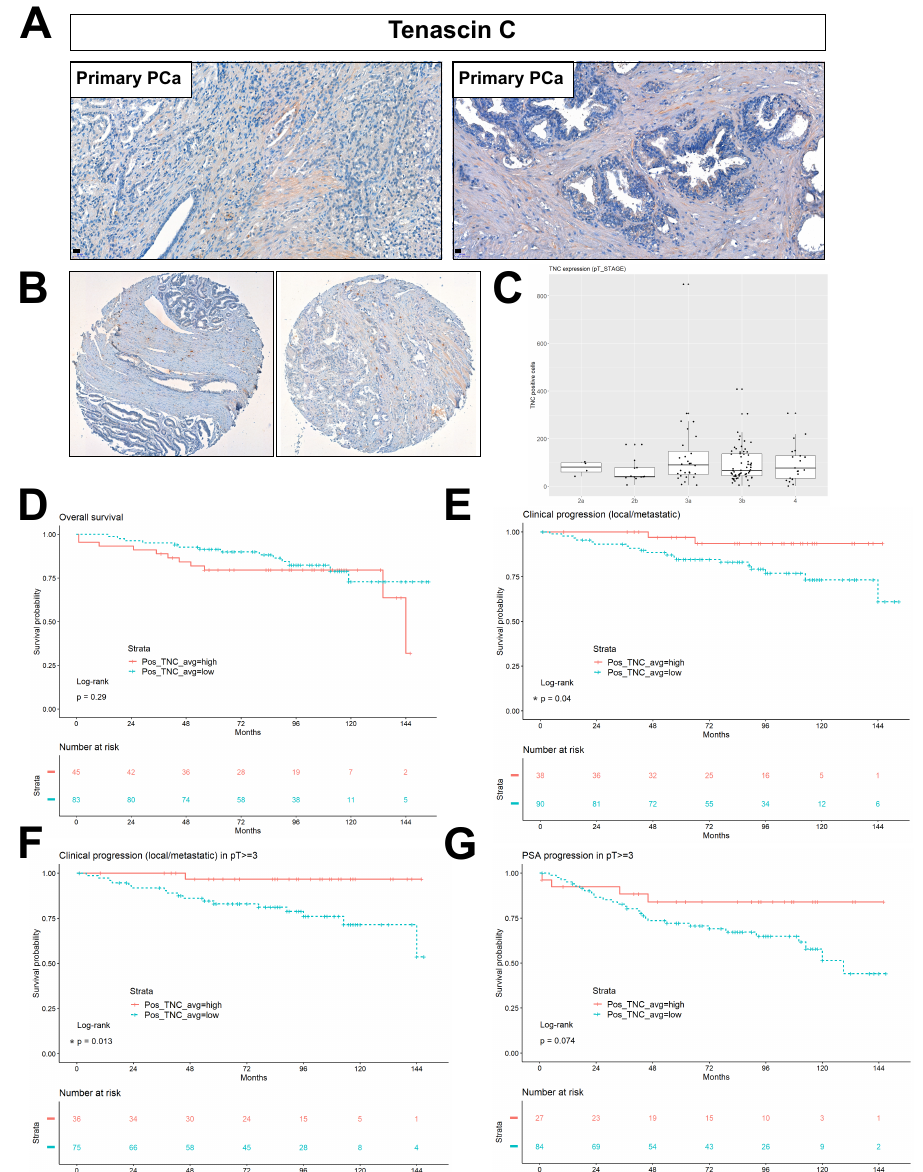
Figure 7. TNC protein expression is a negative metastasis prognostic factor in primary, high-risk PCa. ( A ) Validation of the protein expression and stromal specificity of TNC by immunohistochemistry in primary PCa cases. ( B ) Representative cases of TNC staining on primary PCa Tissue Microarray (TMA) from European Multicenter Prostate Cancer Clinical and Translational Research Group (EMPaCT). ( C ) TNC expression levels in terms of the no. of positive cells in the pT Stage classification. Statistical multiple comparison test, the Wilcoxon rank sum test, was performed; p > 0.05 ( D ) Overall survival probability in patient groups of TNC-high and TNC-low (no. of positive, TNC-expressing cells) ( p = 0.29, ns—non significant). Average value represents the mean of four cores per patient case. ( E ) Clinical progression to the local recurrence or metastasis probability in patient groups of TNC-high and TNC-low expressions ( p = 0.04 and * < 0.05). ( F ) Clinical progression to the local recurrence or metastasis probability among patients of pT Stages 3a, 3b and 4 based on TNC-high and TNC-low expressions ( p = 0.013 and * < 0.05). ( G ) PSA progression probability among patients of pT Stages 3a, 3b and 4 based on the TNC-high and TNC-low expressions ( p = 0.074,